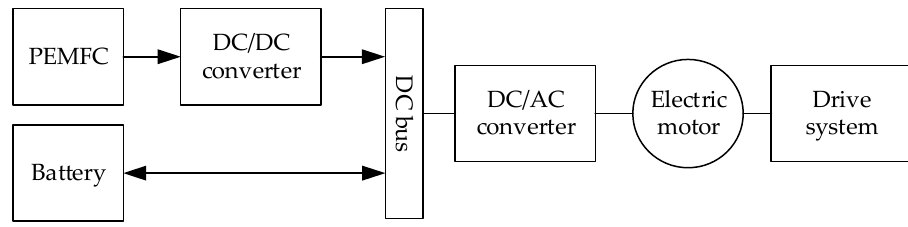
Figure 1. Hybrid powertrain topological structure.